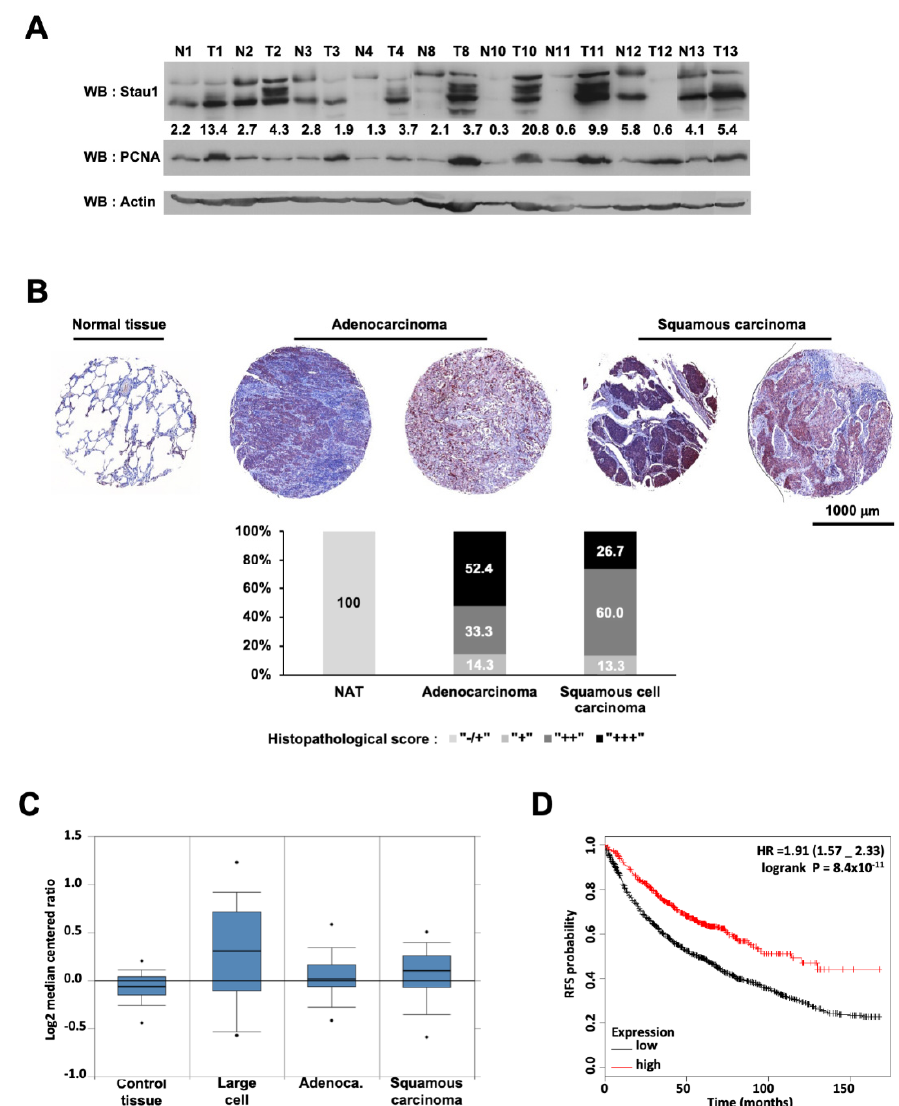
Figure 1. Stau1 is frequently upregulated in lung cancer and positively affects recurrence free survival. ( A ) Western blot analysis of protein lysates prepared from 9 matched samples of lung carcinoma tumors (T) and adjacent non-tumoral tissues (N). Equal amounts of protein from each pair were resolved on SDS-PAGE and immunoblotted with anti-Stau1, PCNA, and β -actin (loading control) an- tibodies. Several blots with the same exposure were assembled. Values represent Stau1 quantification normalized by actin quantification. Quantification was performed with Fiji Software. ( B ) Represen- tative Stau1 immunostaining of normal lung tissue and 4 tumoral tissues, 2 adenocarcinomas and 2 squamous carcinomas from 2 tissue arrays containing triplicates of 5 adjacent/normal, 21 squa- mous cell carcinoma and 16 adenocarcinoma tissues from patients (LC722) and containing triplicates of 8 cases of squamous cell carcinoma, 12 adenocarcinoma, 2 lung large cell carcinoma,1 each of atypical carcinoid and small cell carcinoma, plus 2 normal lung tissue (LC721). The graph represents the distribution in percent of histopathological score for the indicated tissues. ( C ) The level of